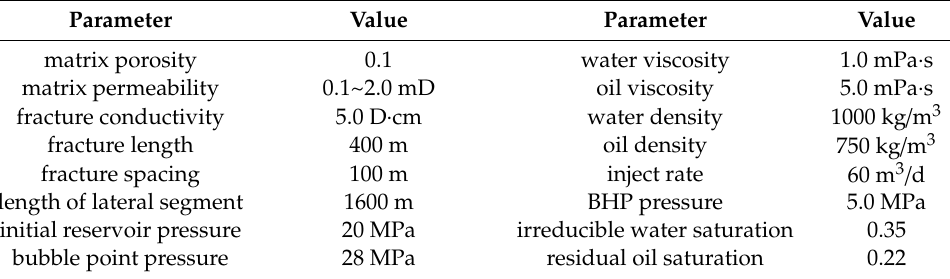
Figure 18. Heterogeneous distribution of matrix permeability in five-spot system. Table 2. Rock and fluid properties for the 3-D heterogeneous waterflood reservoir.